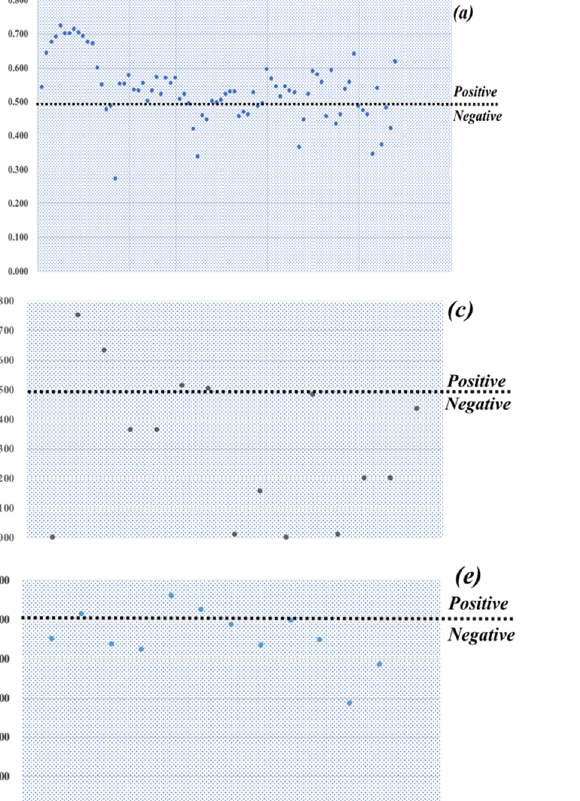
Table 3. Correlation coefficients between public sentiment and the number of messages, personal- authentication accounts, personal accounts, and maximum number of messages per minute.